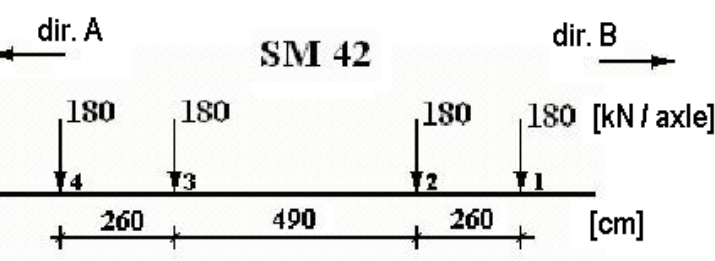
Figure 4. A scheme of loads generated by a SM-42-448 locomotive [author’s scheme].